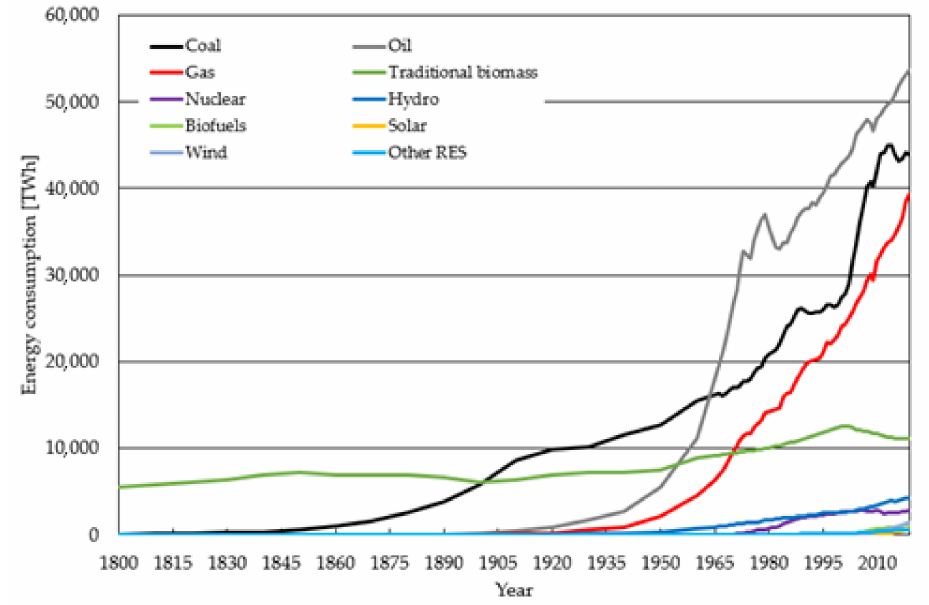
Figure 3. Consumption of primary energy by source (1800–2019)